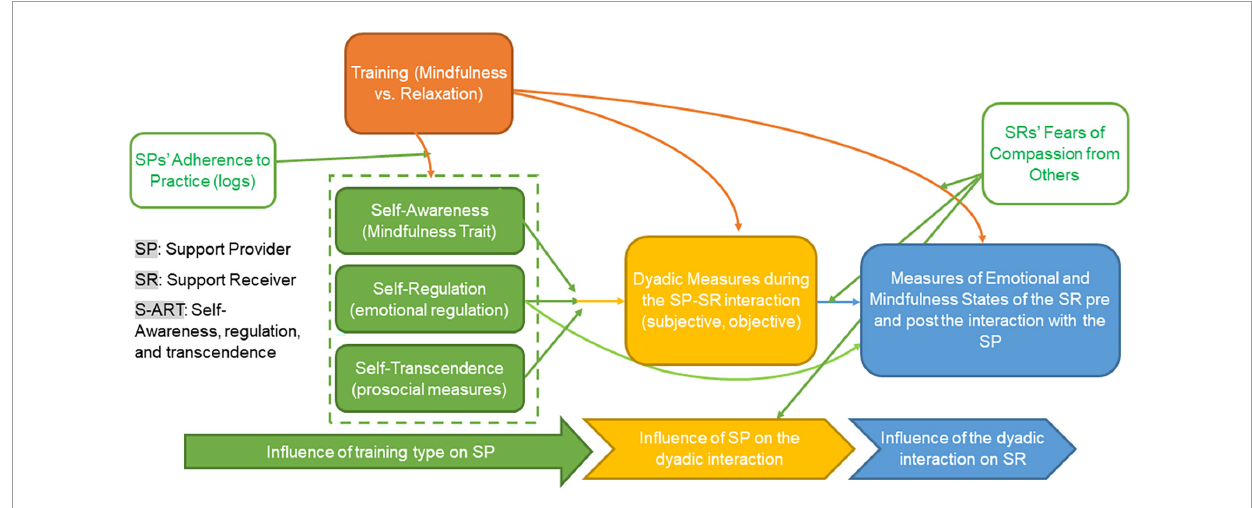
FIGURE1 Schematic representation of the tri-process model of interpersonal